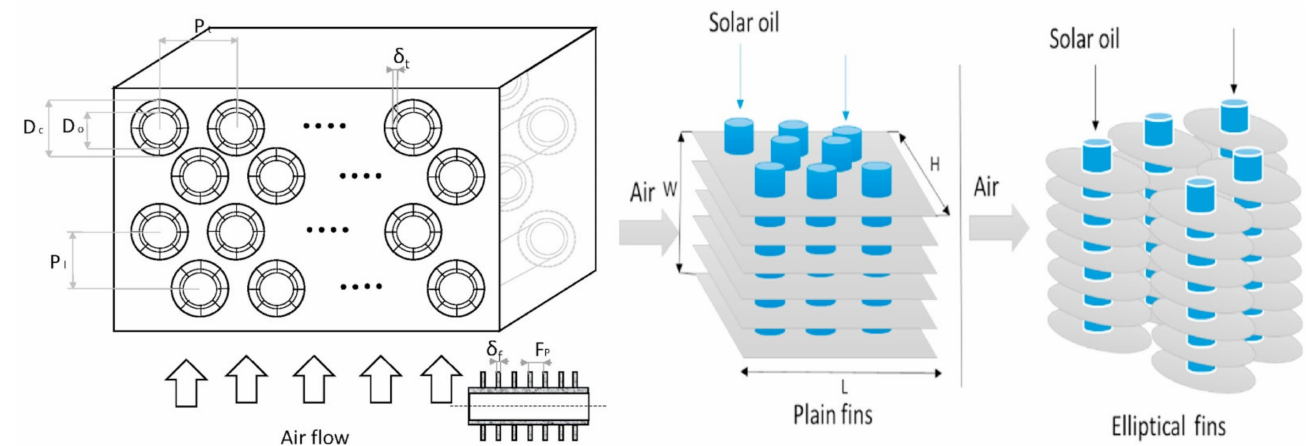
Figure 4. Geometry arrangement of finned tube heat exchanger